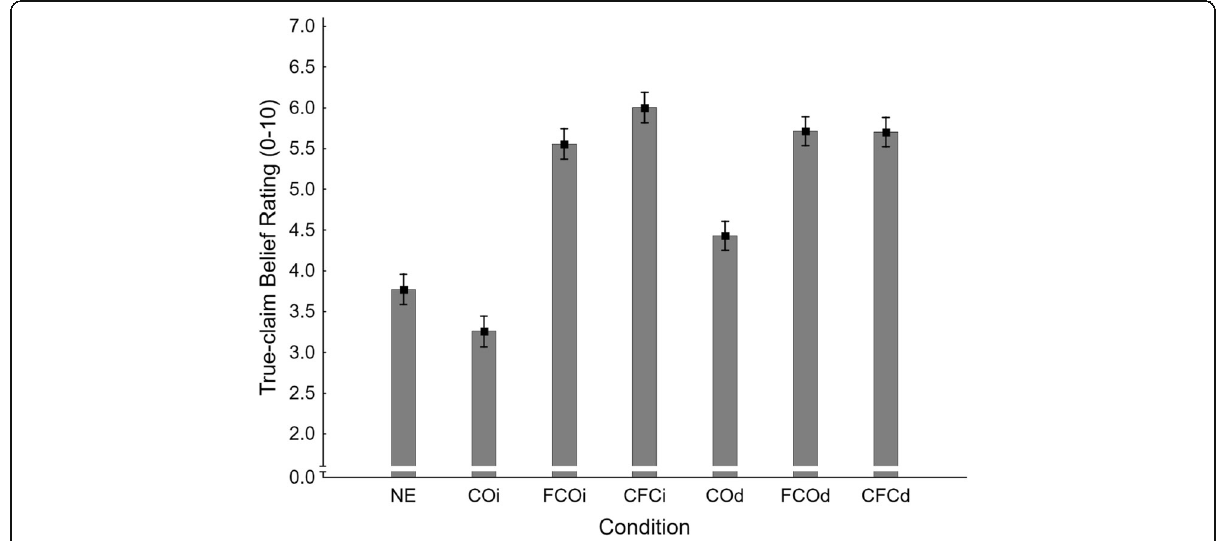
Fig. 10 Mean true-claim belief ratings across conditions NE (no-exposure), COi/d (claim-only, immediate/delayed test), FCOi/d